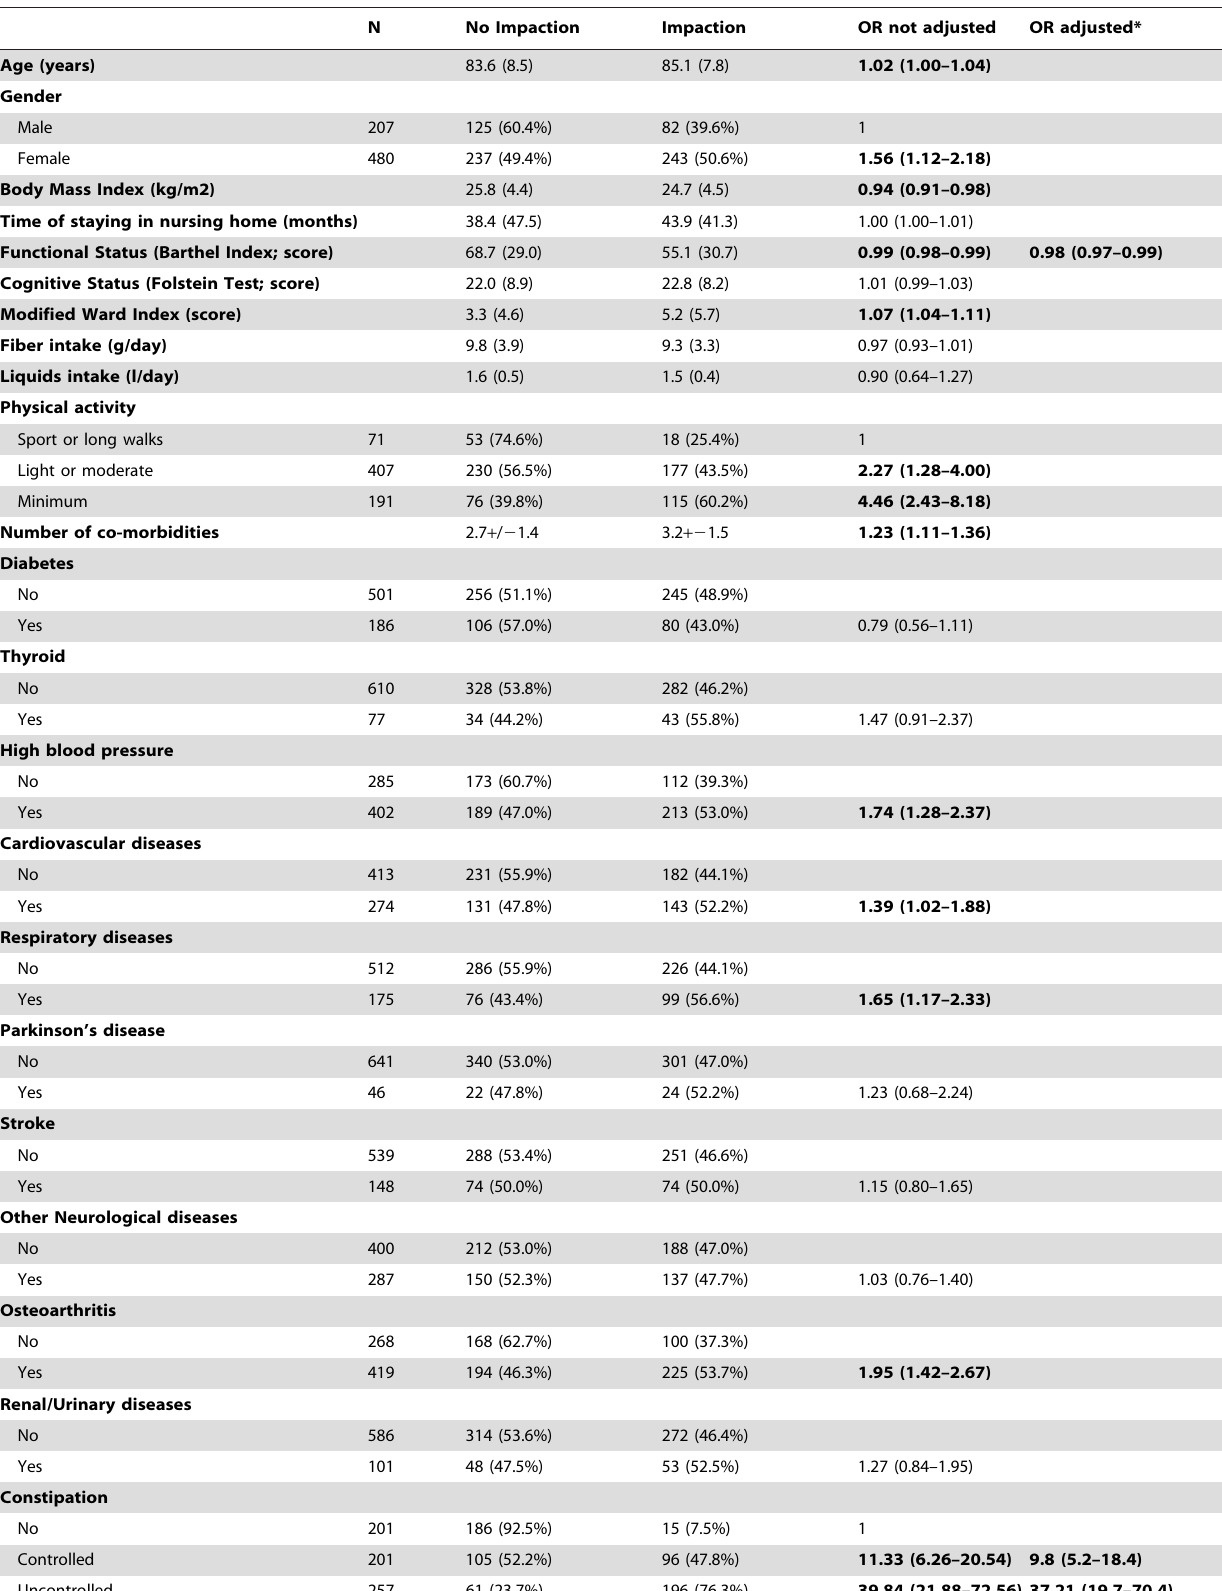
Table 4. Factors associated to Fecal